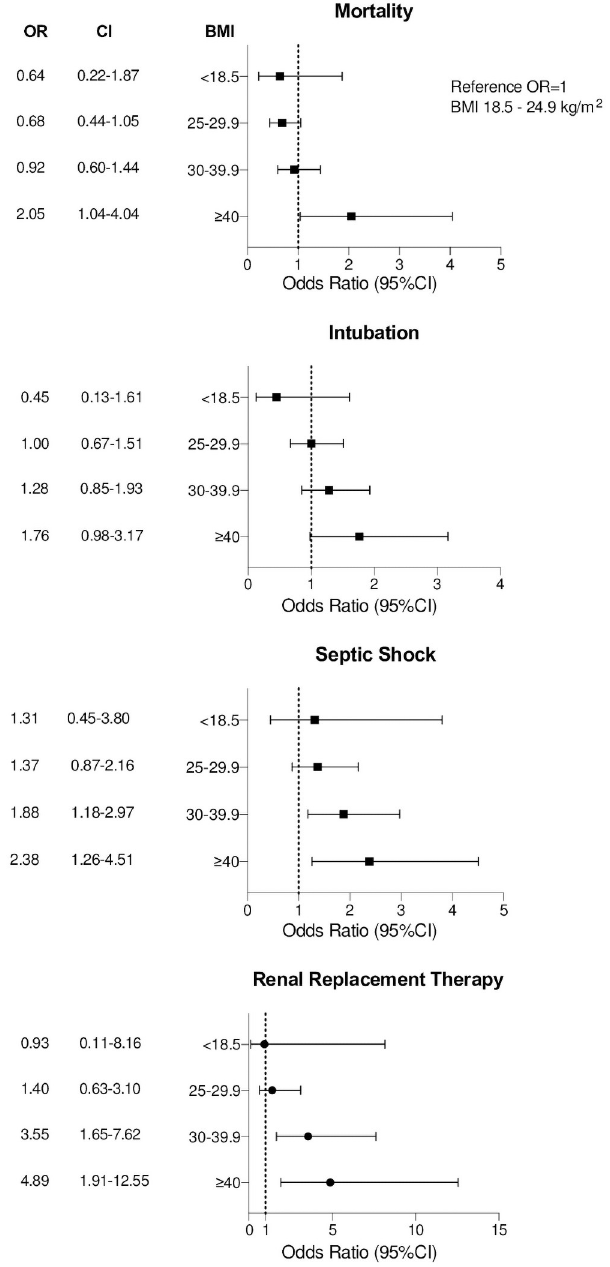
Fig 2. Forest plots of multivariable-adjusted associations between body mass index and end points of mortality, intubation, septic shock, and need for renal replacement therapy.